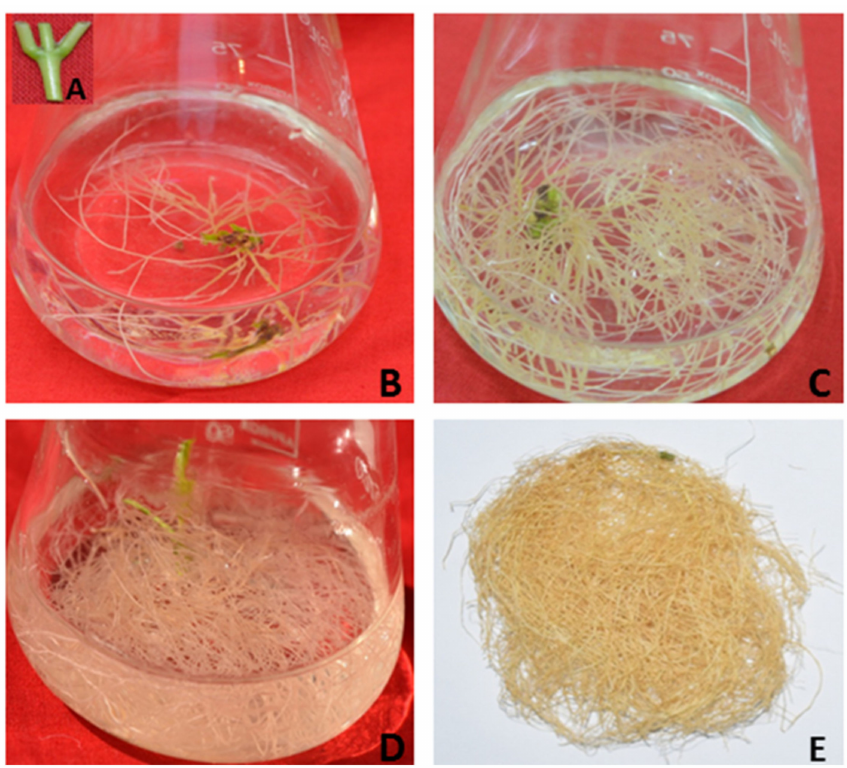
Figure 1. Establishment of adventitious root culture: ( A ): Nodal explant from Allamanda cathartica ; ( B ): initiation of roots from nodal segments; ( C ): growth of root cultures; and ( D , E ): escalation of root